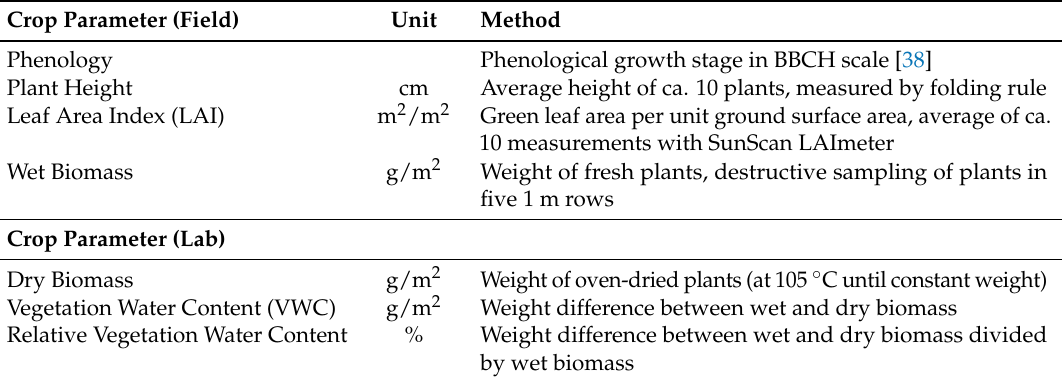
Table 2. Crop Parameters measured during field campaigns 2017 and